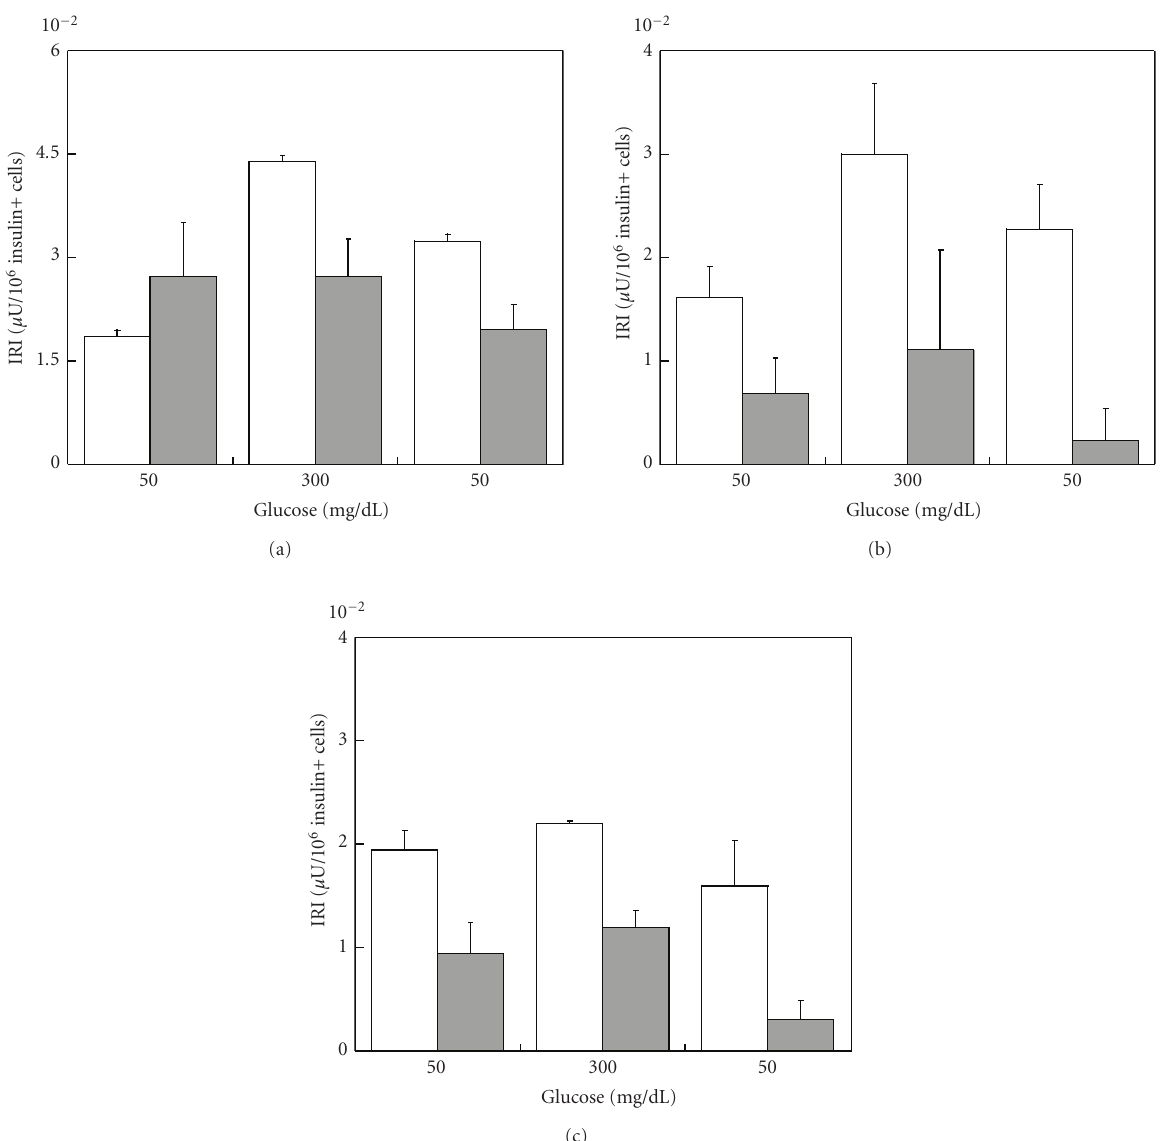
Figure 3: Ratio insulin/insulin+ cell number of control NPI cell monolayers alone (open bars), or NPI cell monolayers cocultivated with microencapsulated SC (gray bars) for 7 (a), 14 (b), and 21 days (c). Data are shown as means ± SD from 3 samples.